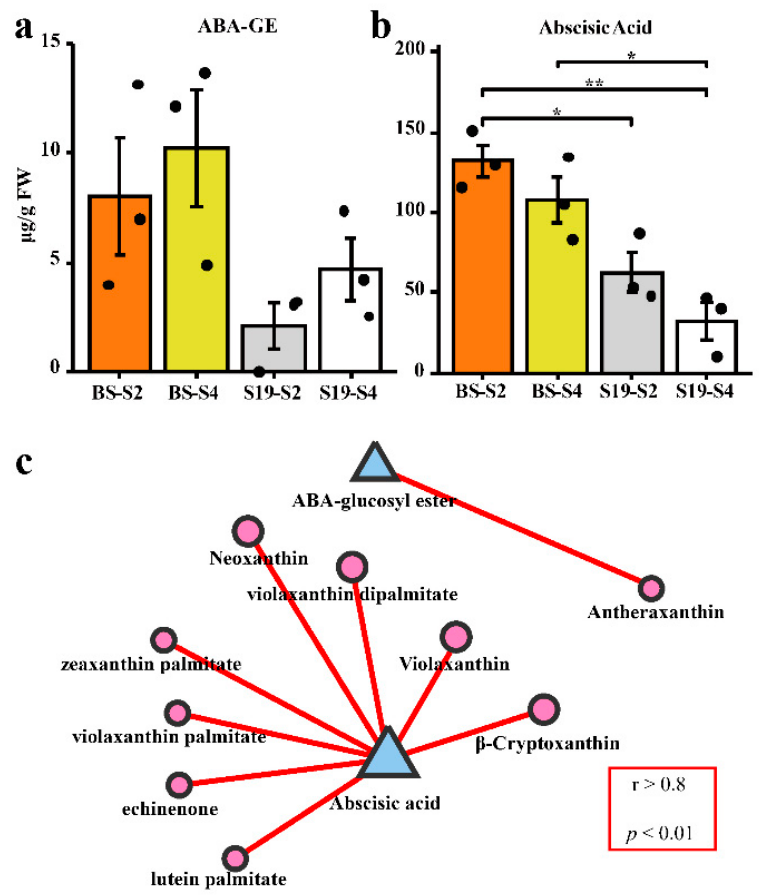
Figure 3. Correlations between ABA levels and carotenoid content. ( a ) Total ABA-GE levels in the indicated samples ( µ g/g FW). ( b ) Total ABA levels in the indicated samples ( µ g/g FW). ( c ) The contents of ABA and ABA-GE were positively correlated with the contents of carotenoid-related components (graphic area is positively correlated with content.). Data are means ± SEM (n = 3). *** p < 0.001, ** p < 0.01, * p < 0.05.